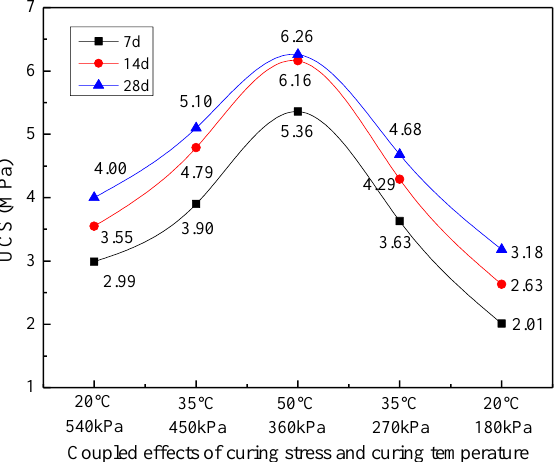
Figure 5. Correlation between the UCS and coupled effects of curing conditions.